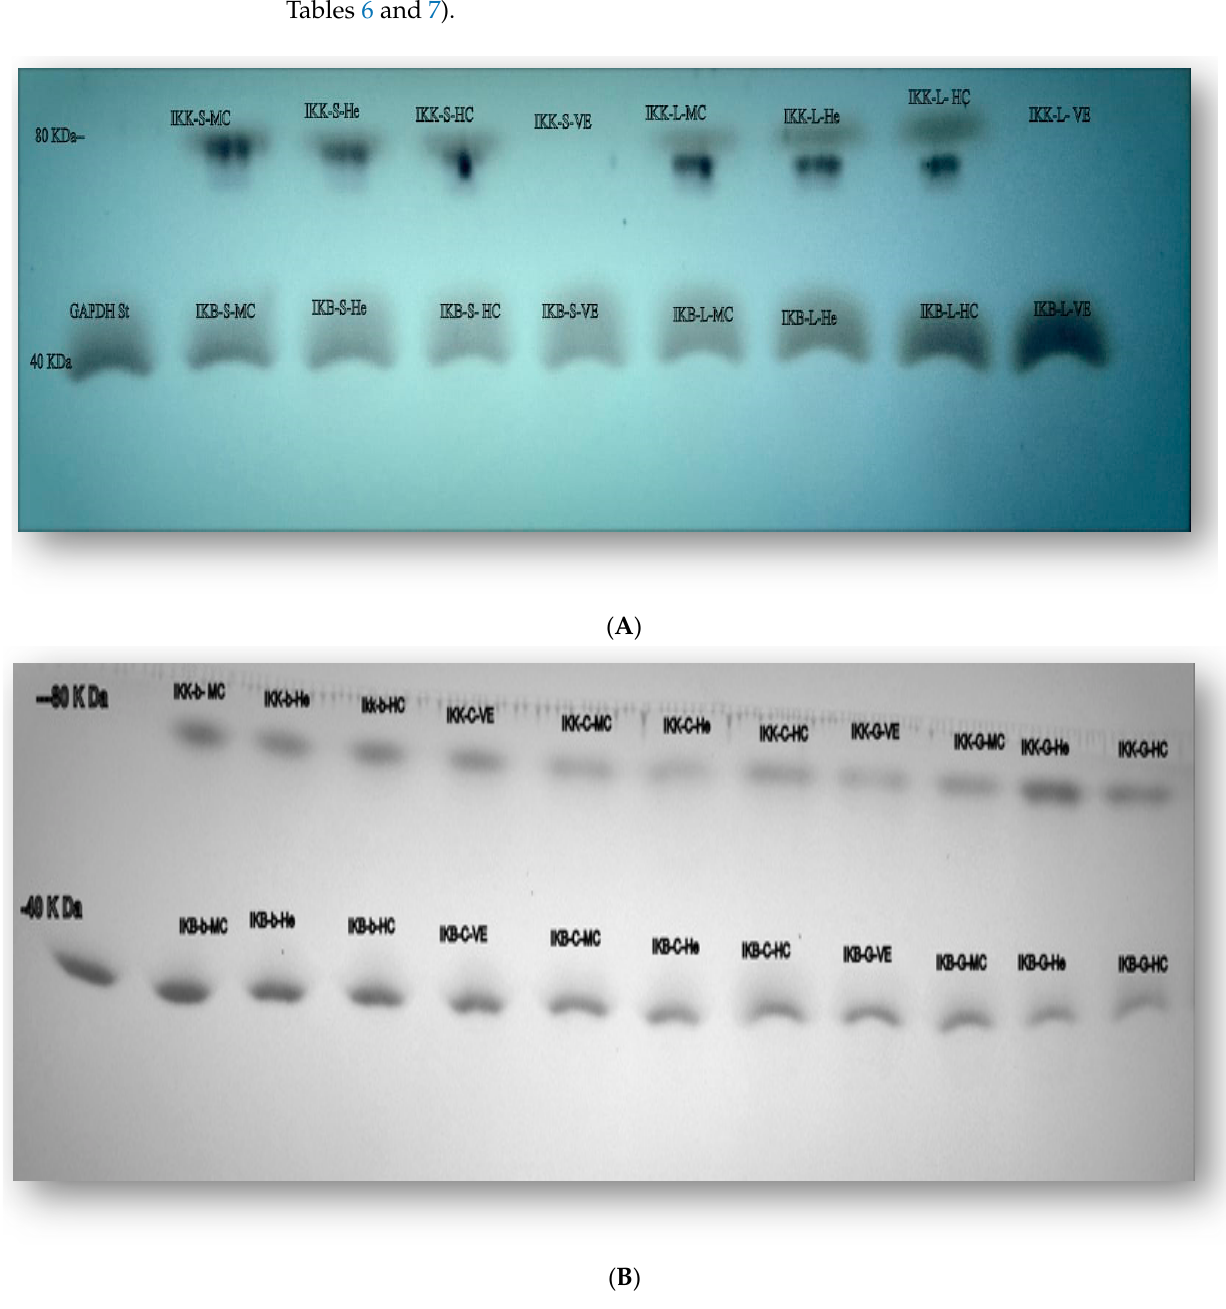
Figure 4. ( A ) IKK- α and IKK- β images for boiled (b), unprocessed (C), and germinated fenugreek seeds (G) on VERO (VE), MCF-7 (MC), HepG2 (He), and HCT-116 (HC) cell lines. The image shows that IKK separated at 80 K Da, and IKB separated around 40 K Da. ( B ) IKK and IKB images for GAPDH, soaked fenugreek seeds (S) and air-dried fenugreek leaves (L) on VERO (VE), MCF-7 (MC), HepG2 (He), and HCT-116 (HC) cell lines, the image also shows that IKK separated at 80 K Da, and IKB separated around 40 K Da.